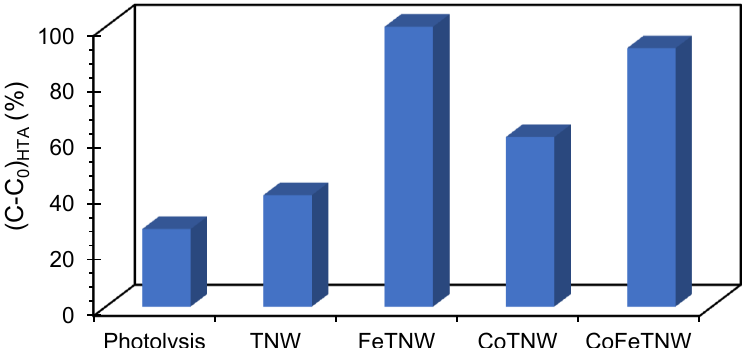
Figure 4. HTA concentration after 20 min of irradiation of a TA solution (3 mM, 150 mL) using the prepared samples as photocatalyst.